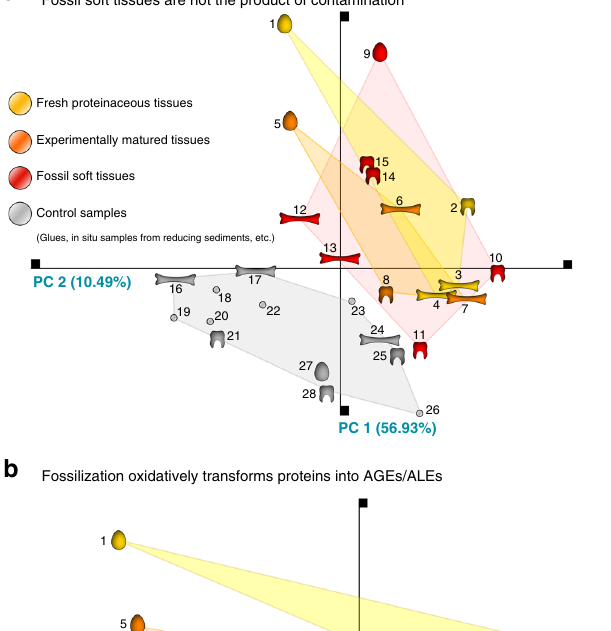
Specimen photography and microscopy . All specimens (Fig. 2, Supplementary Tables 1 – 4, Supplementary Figs. 1, 2) and available sediment samples (Supple-